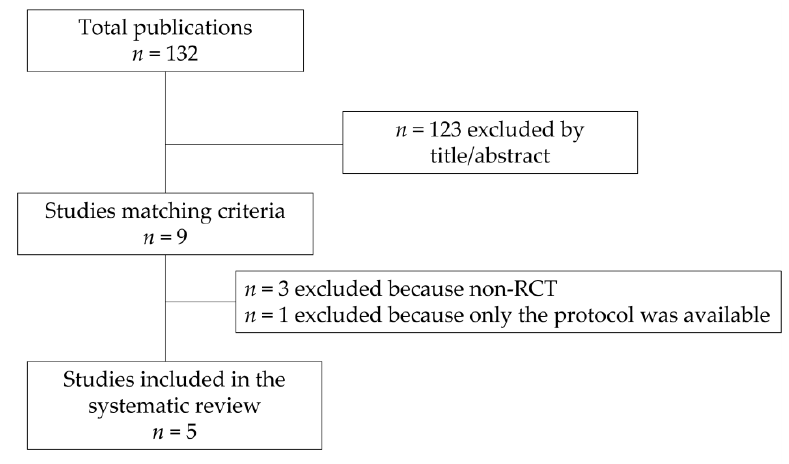
Figure 1. Flow diagram of the study search process. Table 1. Study and population characteristics.